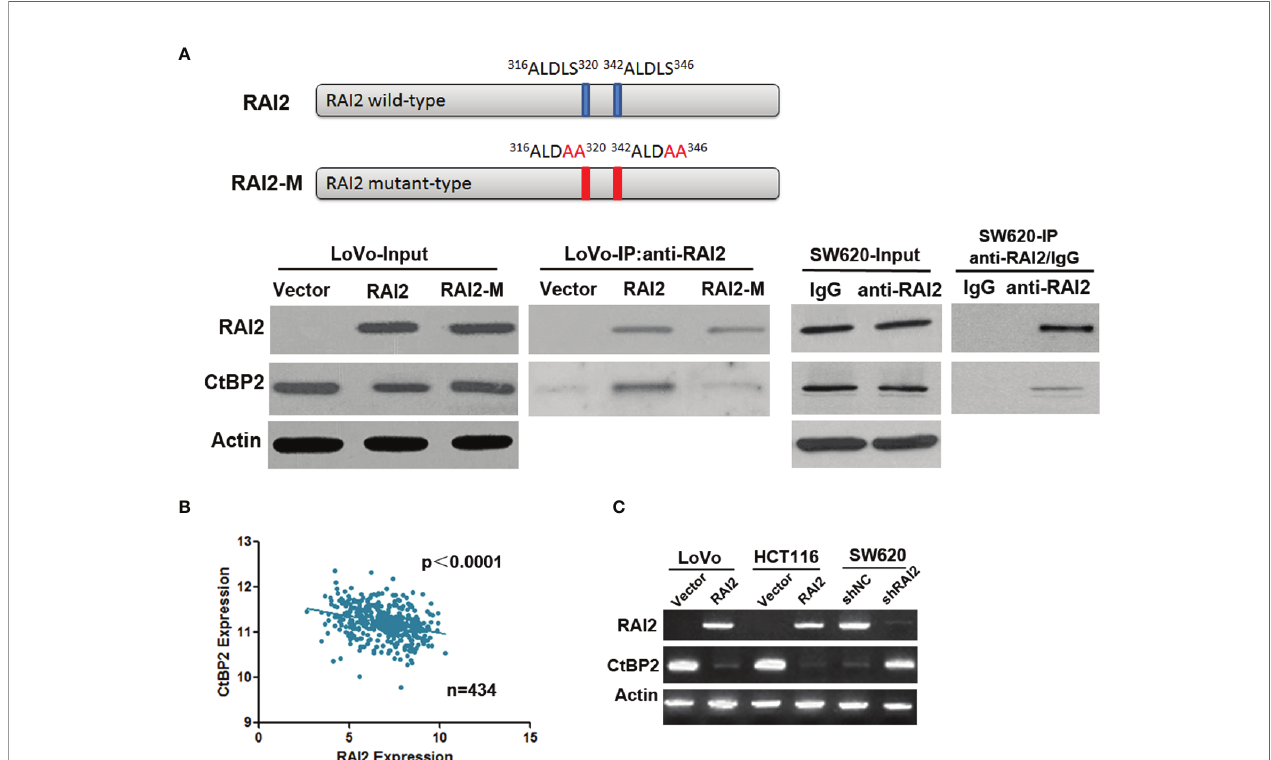
FIGURE 1 | RAI2 expression is negatively correlated with that of CtBP2. (A) Upper panel: A schematic of RAI2 domain organization and the mutant sites of mutant type RAI2 (RAI2-M); lower panel: Coimmunoprecipitation (Co-IP) analysis of RAI2 and CtBP2 interaction by anti-RAI2 antibody using cell lysates from LoVo cells transfected with empty vector, RAI2 expression vector or RAI2 mutant vector. And Cell lysates from SW620 cells were also used for Co-IP detection to analyze the endogenous interaction between CtBP2 and RAI2 by RAI2 antibody, with IgG group as a negative control. Input: before any antibodies were added. (B) The reciprocal mRNA expression between CtBP2 and RAI2 in 434 cases of colorectal cancer tissues from the TCGA dataset. (C) RT-PCR detection of RAI2 and CtBP2 expression in LoVo/HCT116 cells with or without RAI2 re-expressed and in SW620 cells with or without RAI2 knocked